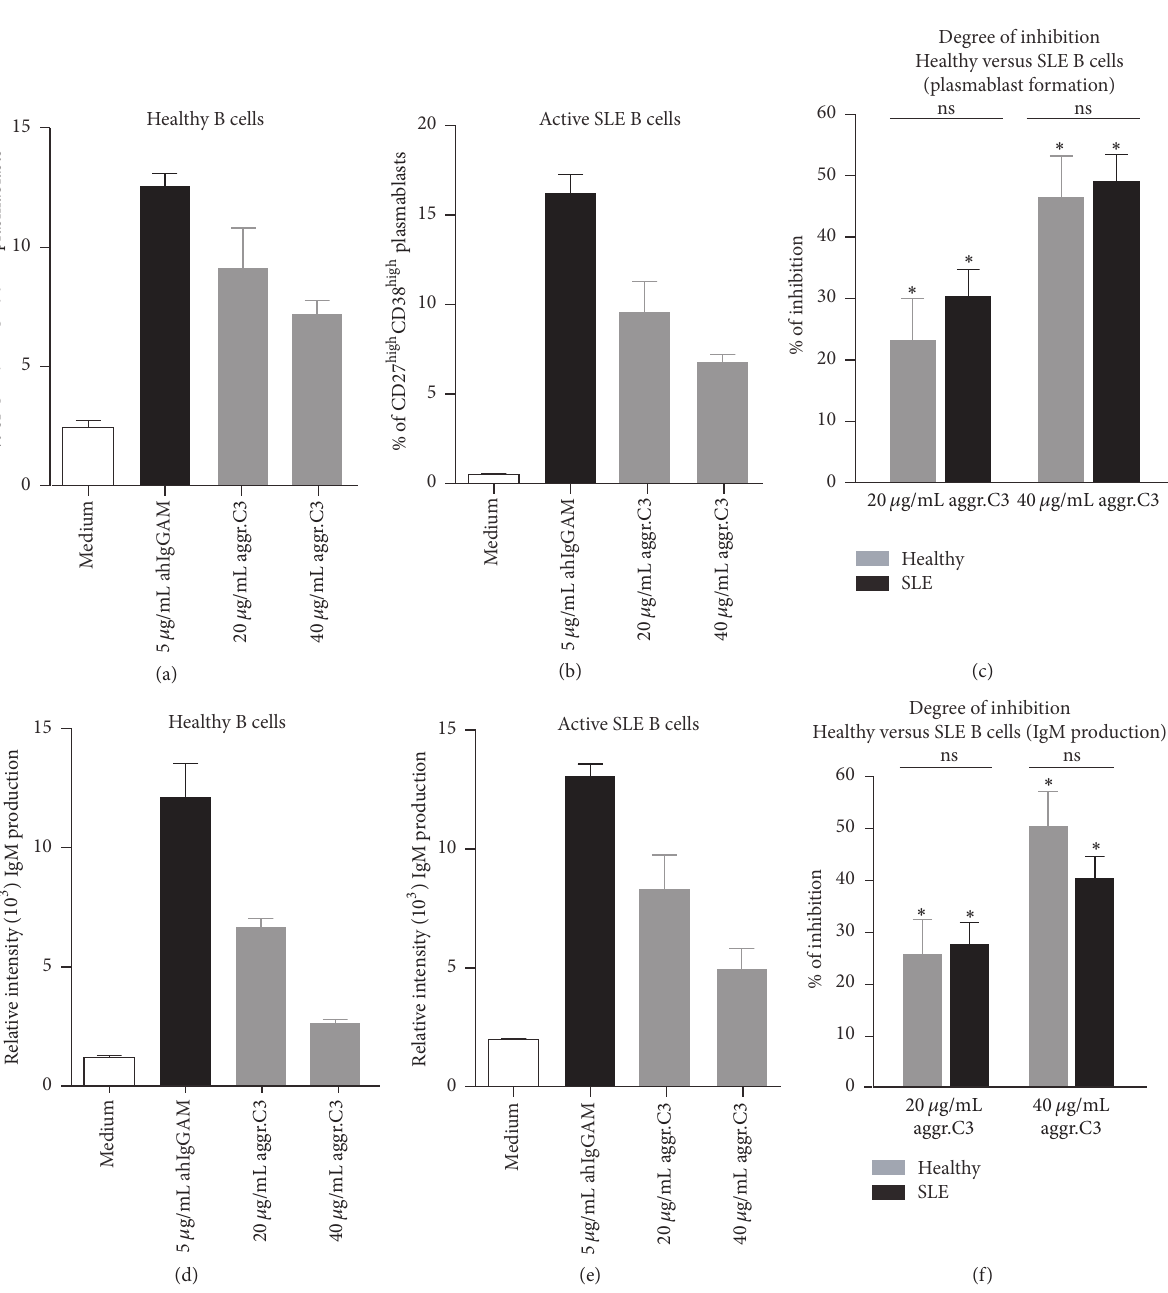
Figure 3: Impact of CR1 clustering on BCR-induced plasmablast formation (a–c) and IgM secretion (d-e) of human B cells. 2 × 10 5 B cells isolated from healthy donors (a and d) or active SLE patients (b and e) were activated for 6 days with the F(ab’) 2 fragment of anti-human IgG+M+A Ab (5 𝜇 g/mL) in the presence of 50ng/mL IL-10, IL-2, and IL-6 and treated with different concentrations of heat-aggregated C3. (a and b) The percentage of CD 19 low CD 27 high CD 38 high plasmablasts was determined at day 6 by flow cytometry. Data show mean frequency of CD 19 low CD 27 high CD 38 high cells ± SD of duplicate samples. One representative experiment of six is shown. (d and e) Supernatants of cultured cells were collected on day 6 and were measured for secreted IgM by reverse phase protein microarray. Data are expressed as mean ± SD relative fluorescence intensity of triplicate measurements. Results are representative of six independent experiments in the case of both healthy donors (d) and active SLE patients (e). (c and f) Results showing percent of inhibition mediated by aggregated C3 are mean % of inhibition ± SEM of six independent experiments and correlated with the CR1-agonist untreated sample (see Section 2, Permutation-test; ∗ 𝑃 < 0.05 and ns 𝑃 > 0.05